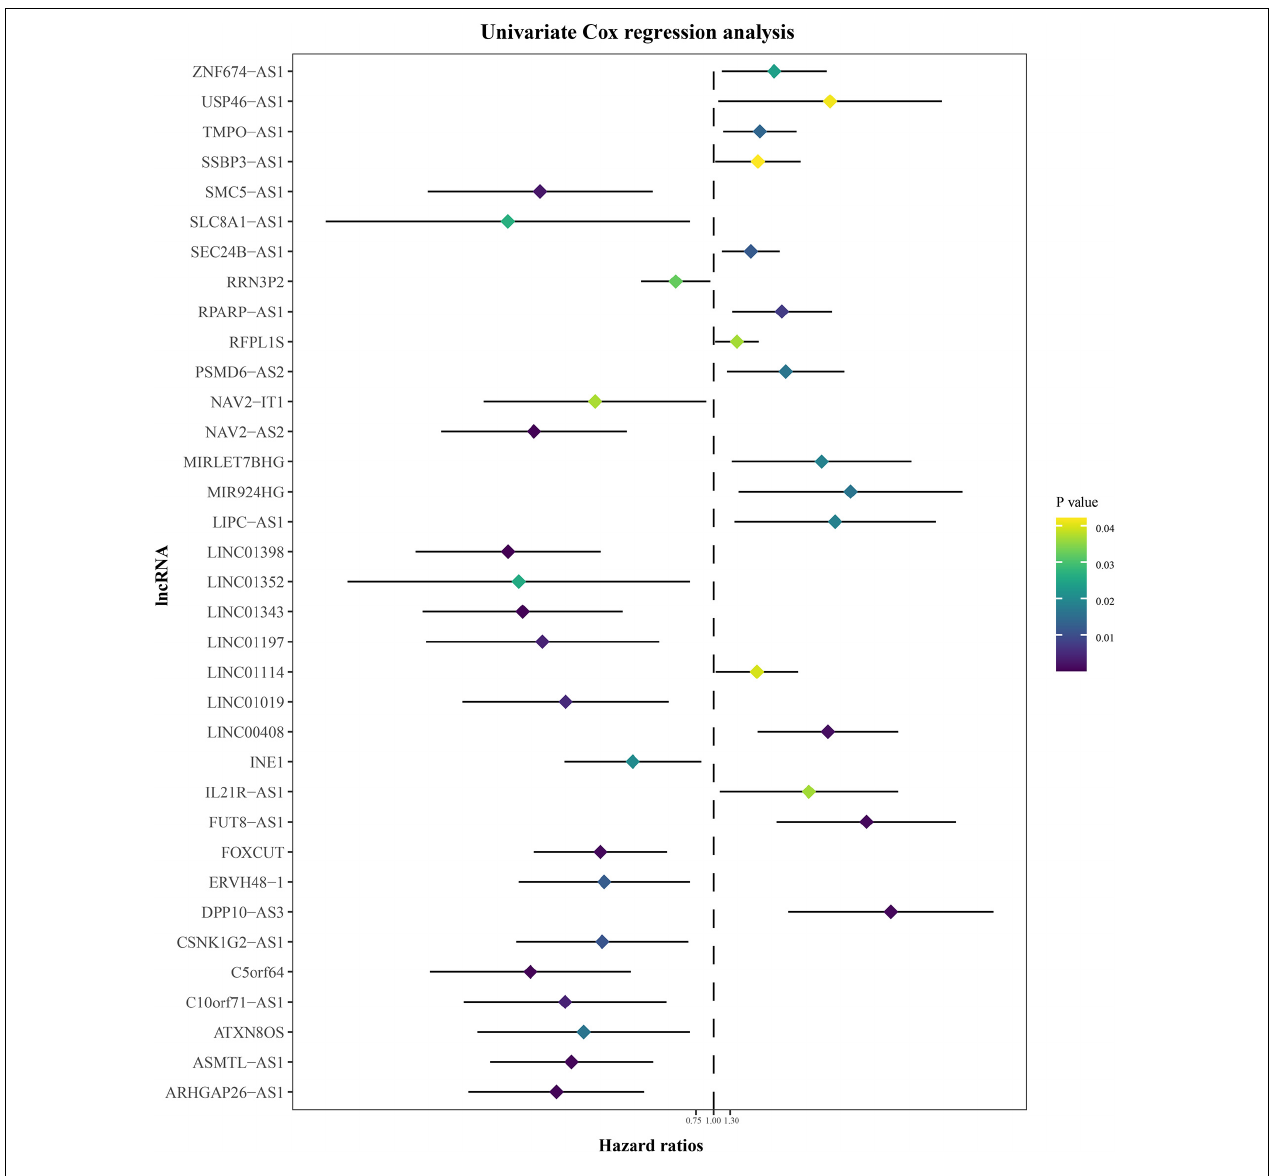
FIGURE 3 | Univariate Cox regression analysis of immune-related differentially expressed